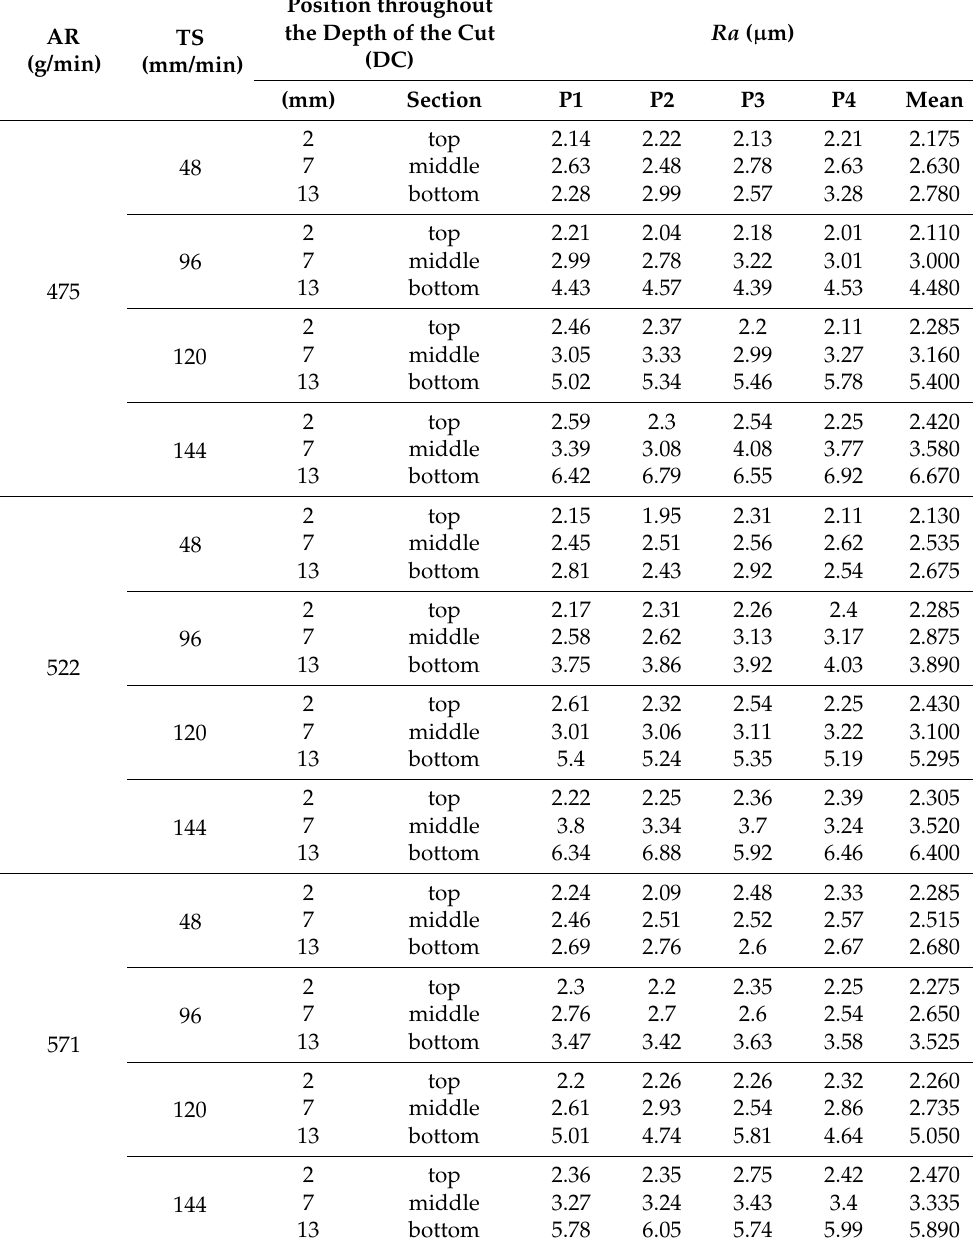
Table 5. Ra values in the machining of the workpiece with 15 mm